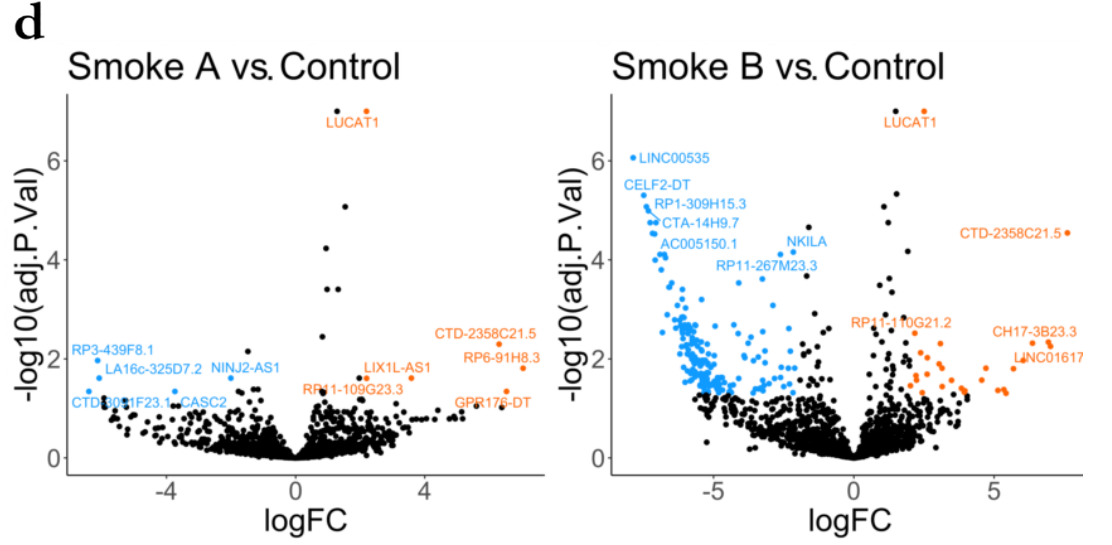
Figure 2. Differential lncRNA signatures correlate with DSE for different fuels. ( a ). Principal component analysis (PCA) of variance stabilized transformed (vst) lncRNAs data, n = 2326; ( b ) Venn diagram of differentially expressed lncRNAs; (left) includes all lncRNAs with a false discovery rate adjusted p -value < 0.05 (right) is a subset of (left) with an imposed log2 fold change threshold of greater or less than 6 or − 6; ( c ). Expression heat map of variance stabilized transformed (vst) lncRNAs data showing the largest changes in expression patterns compared to control (NT), this is the set of lncRNAs in (b-right), n = 48; ( d ) Volcano plot of each pairwise comparison to control (NT), highlighted genes are down (blue) or upregulated (orange), with a false discovery rate adjusted p -value < 0.05 and a log2 fold change of greater or less than 2 or − 2.